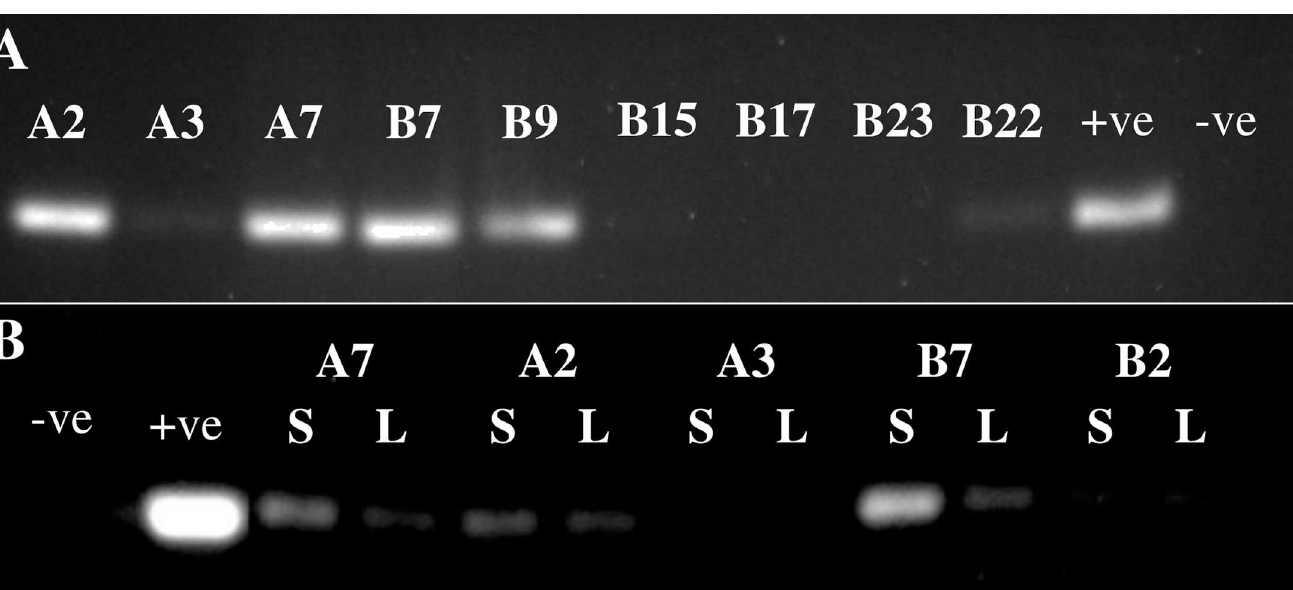
PLOS NeglectedTropical Diseases | https://doi.org/10.1371/journal.pntd.0006532 June 28,